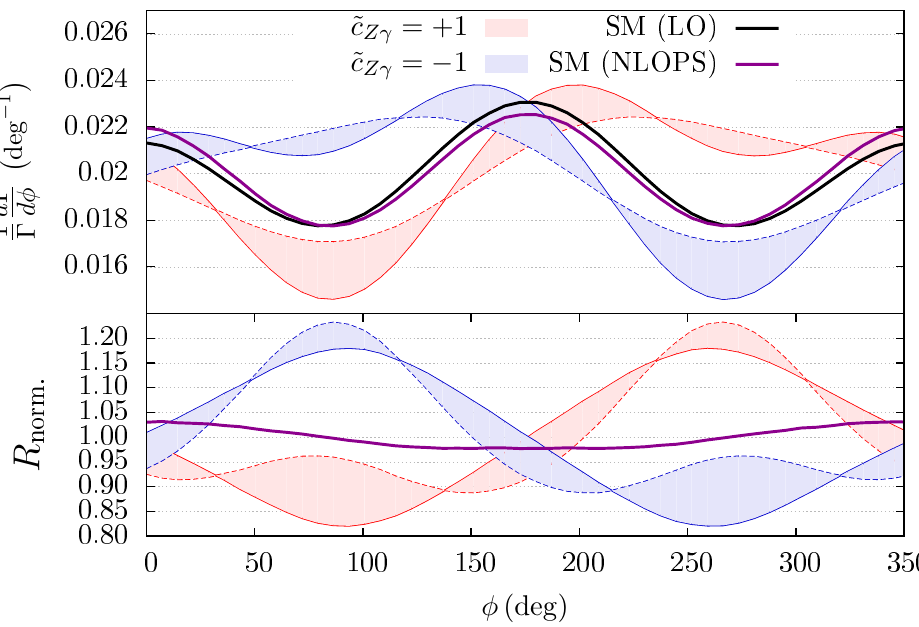
1. Lower panels: normalized (cid:0)